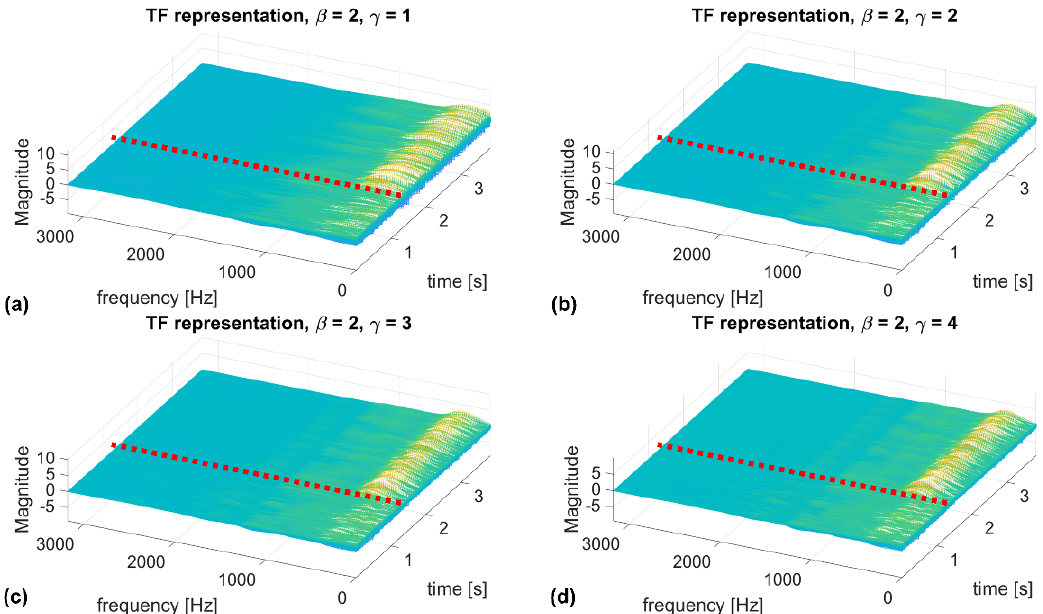
Figure 8. Time–frequency distributions corresponding to the results shown in Figure 7 ( β = 2 and γ equal to ( a ) 1, ( b ) 2 , ( c ) 3 , and ( d ) 4.).